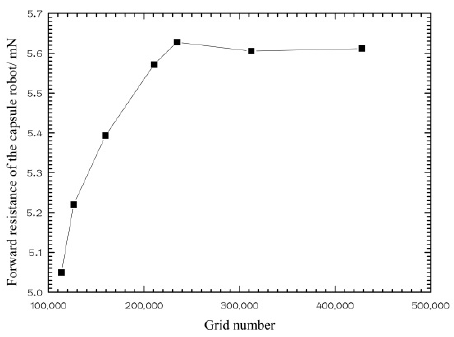
Figure 3. Grid independence analysis diagram ( d = 18 mm).